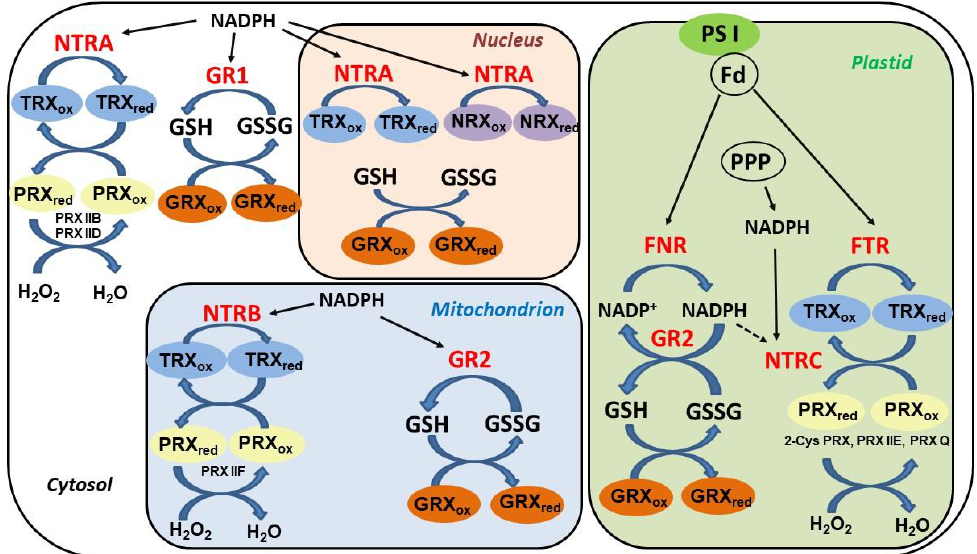
Figure 2. Overview of components and reduction pathways of the thiol-redox system in the main subcellular compartments of plant cells. Fd, ferredoxin; FNR, ferredoxin NADP+ reductase; FTR, ferredoxin thioredoxin reductase; GSH, reduced glutathione; GSSG, oxidized glutathione; GR, glutathione reductase (types 1 and 2); GRX, glutaredoxin; NTR: NADPH thioredoxin reductase (three types: A, B, and C); TRX, thioredoxin; PPP, pentose phosphate pathway; PRX, peroxiredoxin; PS I, photosystem I.